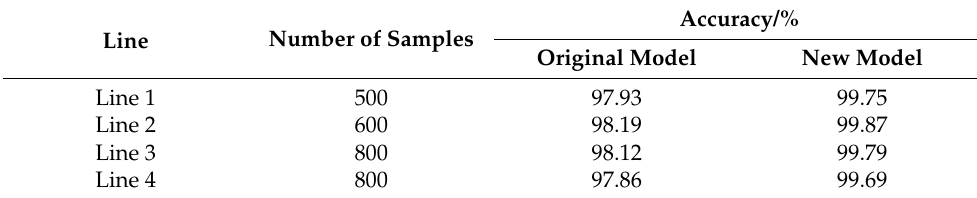
Table 7. Line selection results after distributed generators